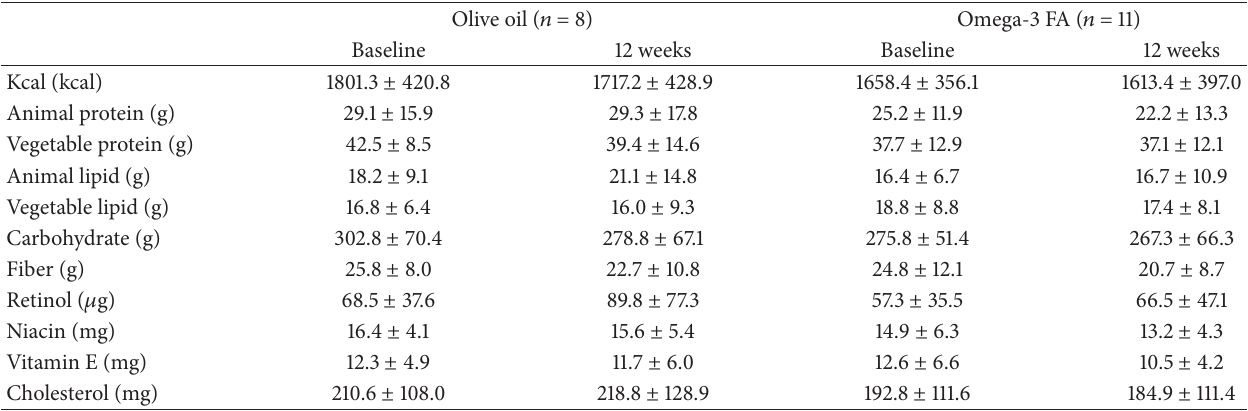
Table 3: Dietary consumption of foods and nutrients.